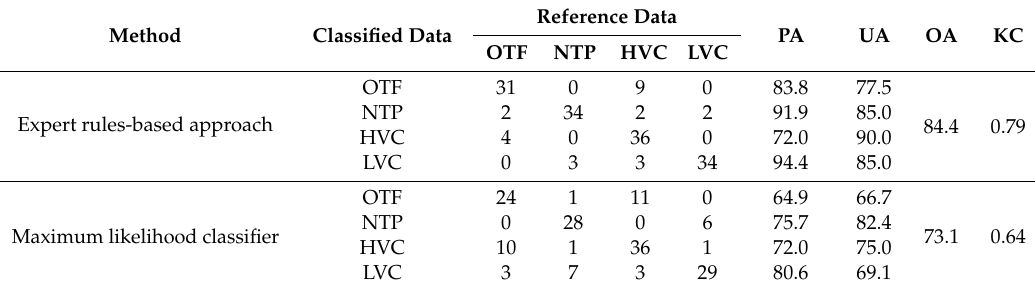
Table 3. Comparison of Torreya forest classification accuracy assessment results between the expert rules-based approach and maximum likelihood